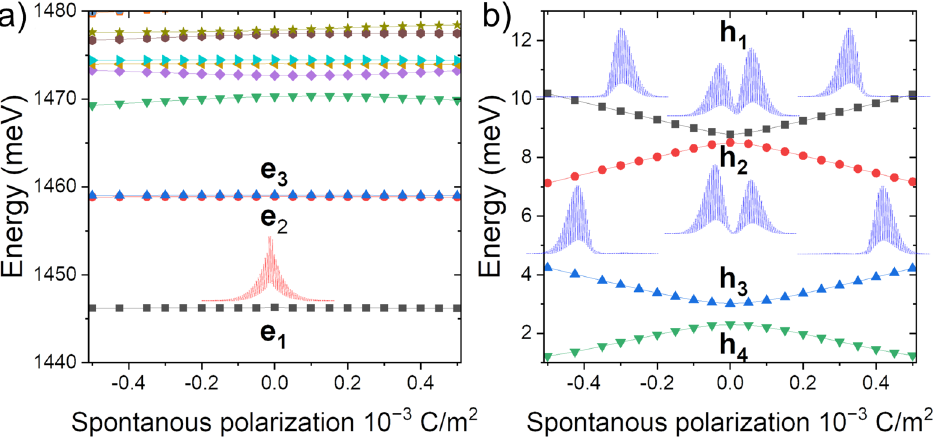
Figure 7. ( a ) spontaneous polarization (for P sp = 0.5 × 10 − growth axis. The spontaneous polarization leads to a step-like potential with a triangular-like quantum well in the ZB region and potential bias between both WZ sections. ( b ) the potential step increases (as spontaneous polarization charge builds up) with the increasing quantum dot height (ZB region thickness).